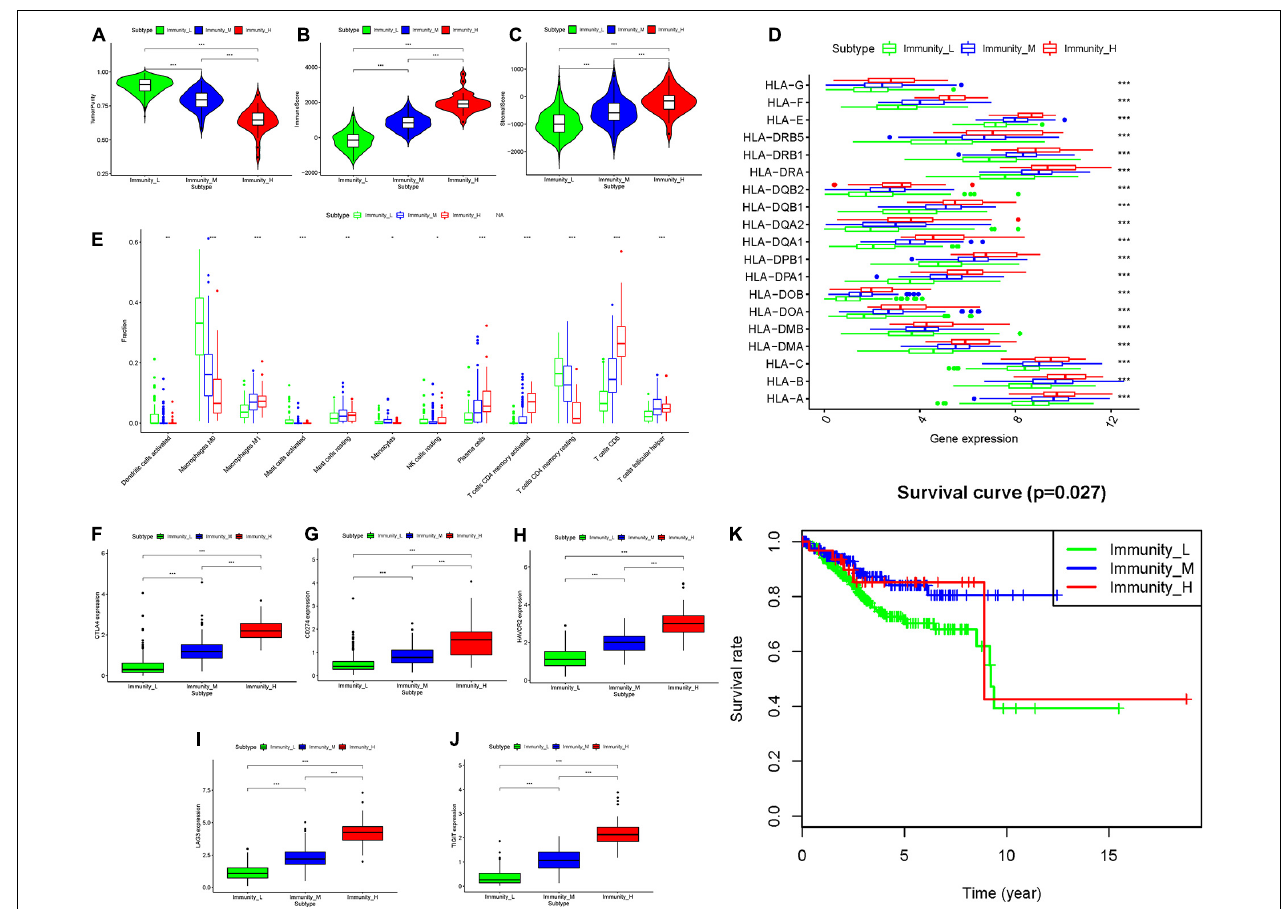
FIGURE 3 | Three UCEC subtypes displayed different phenotypes. (A–C) The difference in Tumor Purity, Immune Score and Stromal Score in three UCEC subtypes. (D) The mRNA expression of HLA genes among UCEC subtypes. (E) The proportion of different immune cells in three UCEC subtypes. (F–J) The mRNA expression of 5 immune checkpoint molecules (CTLA4, CD274, HAVCR2, LAG3 and TIGHT) in three UCEC subtypes. (K) The survival curve exhibited that the prognosis of patients among UCEC subtypes is different. *0.01 ≤ P < 0.05; *0.001 ≤ P < 0.01; *** P < 0.001.